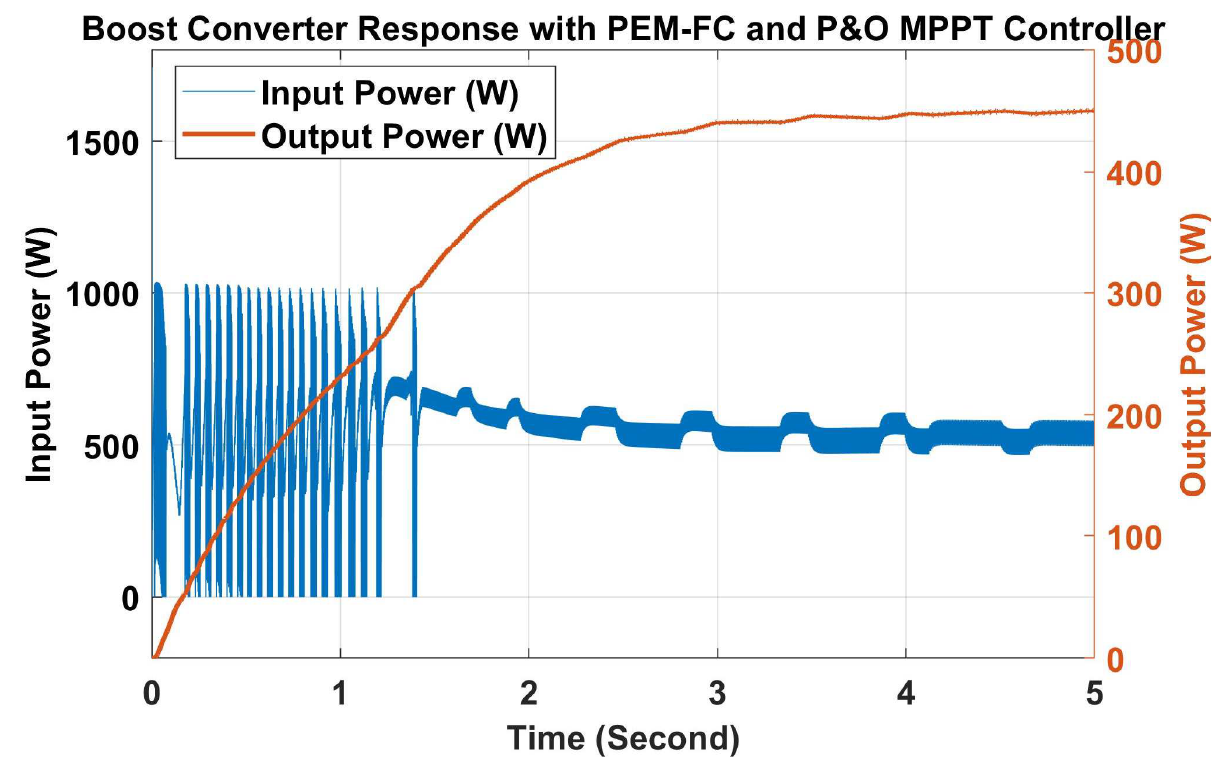
Energies 2022 , 15 , x FOR PEER REVIEW Figure 8. Input and Output Voltage of Buck Converter with WTIG System and P-&-O MPPT Controller.